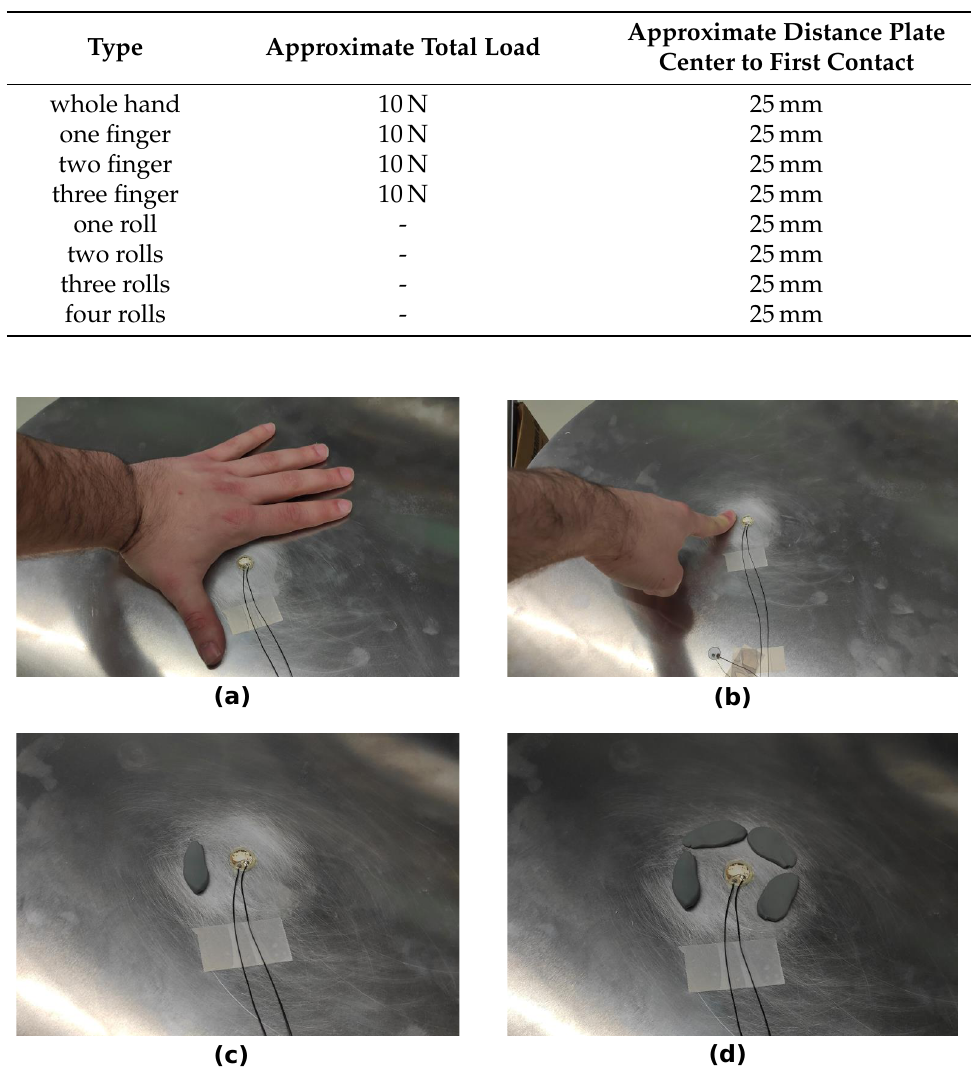
Figure 6. Examples of artificial disturbances: ( a ) hand next to PWAS; ( b ) one finger next to PWAS; ( c ) one modeling compound roll next to PWAS; ( d ) four modeling compound rolls next to